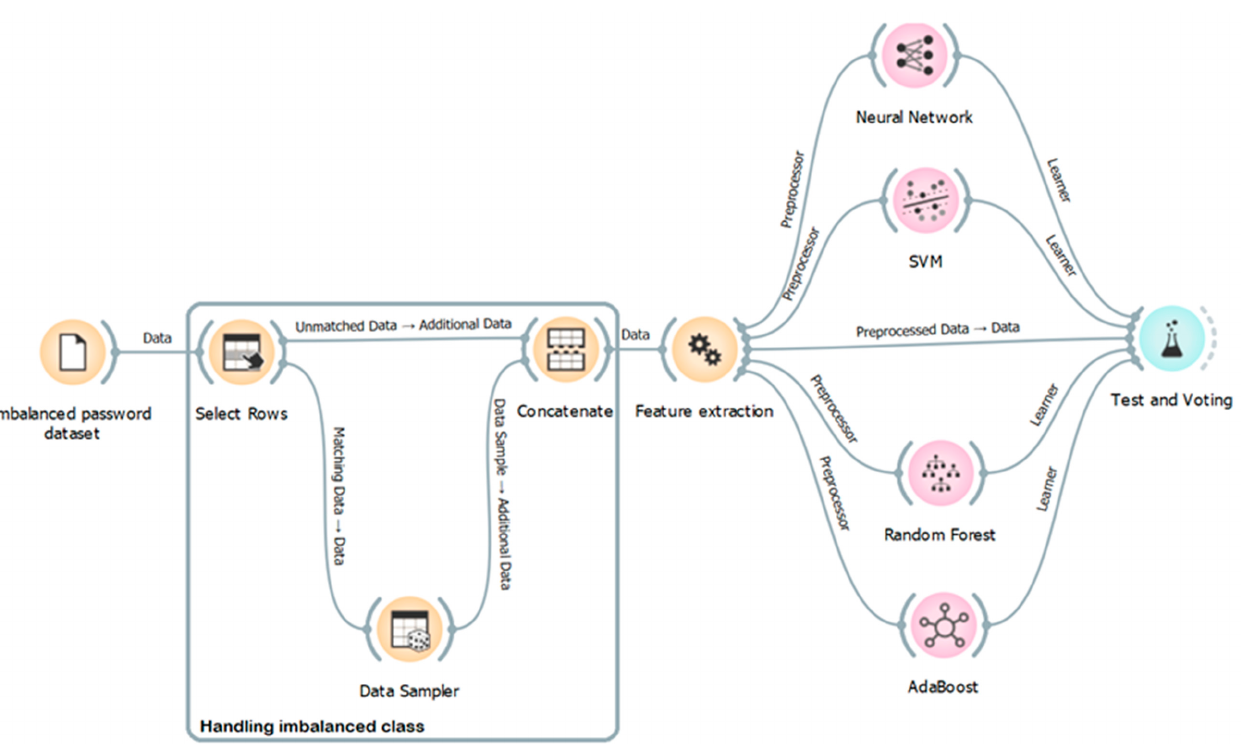
Figure 7. Architecture of password strength classification using ensemble learning.